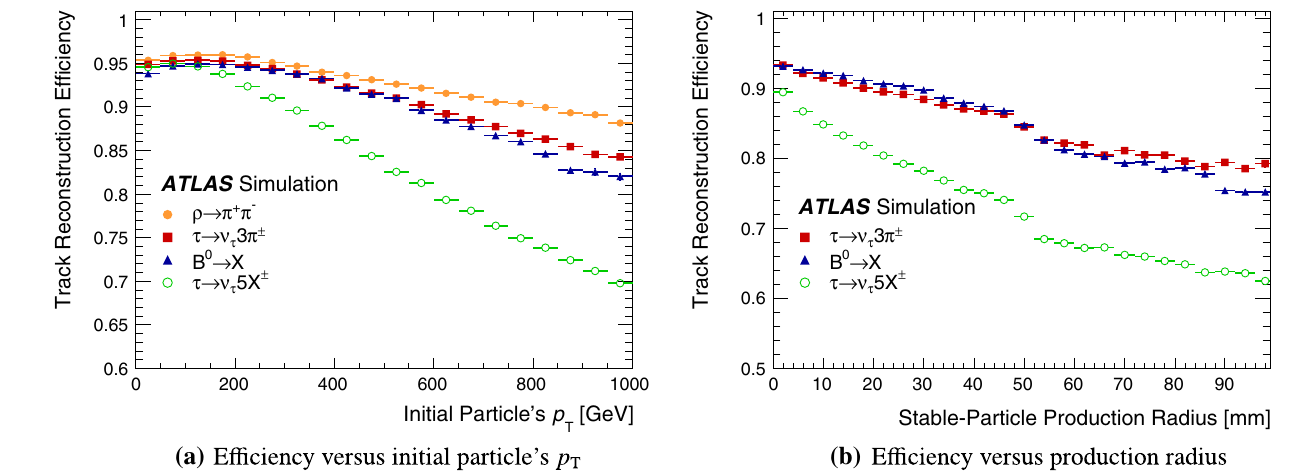
R(jet,particle) Δ